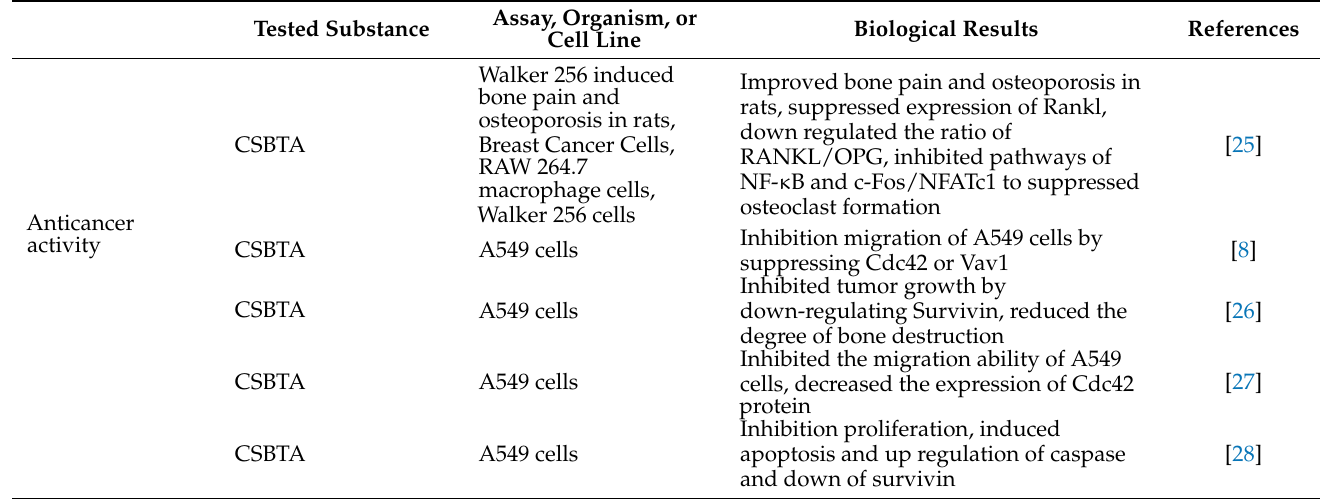
Table 2. Pharmacological activities of Corydalis saxicola